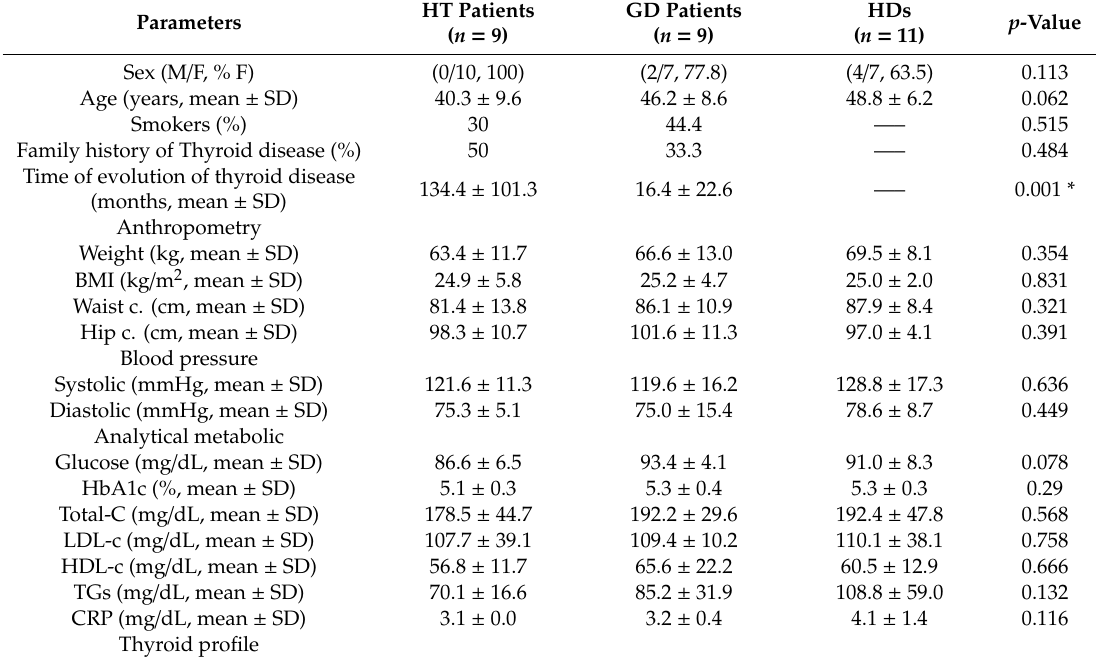
Table 1. Clinical and demographic characteristics of patients and healthy